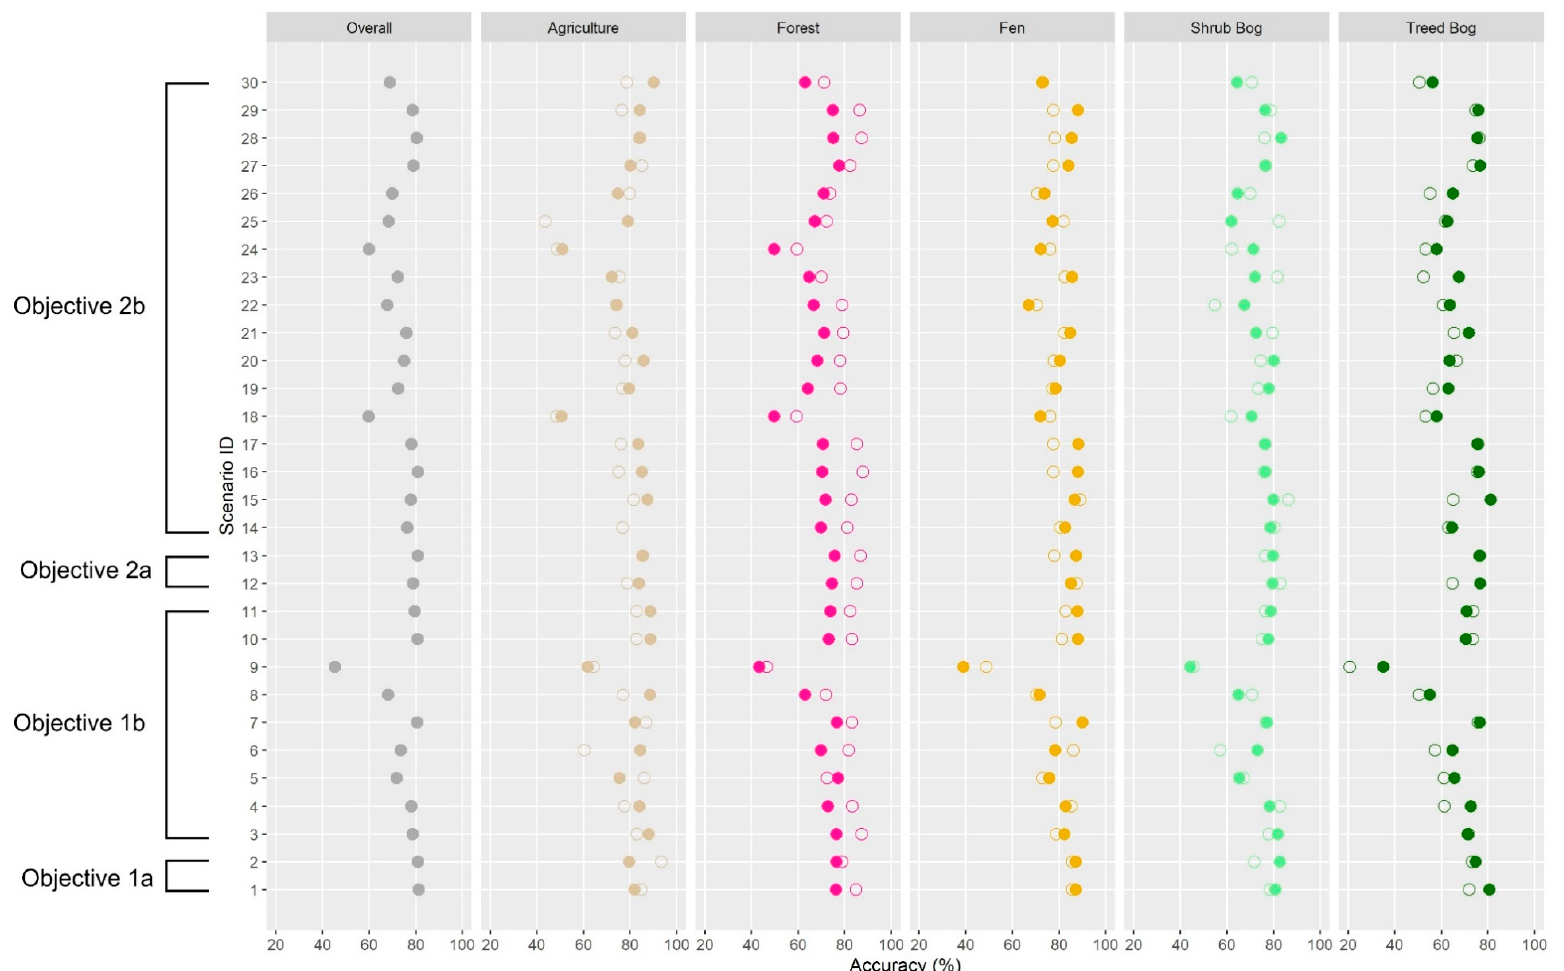
Figure 4. Overall, user’s, and producer’s accuracy per class for the 30 scenarios. Scenario information (including which variables are included in each) is listed in Table 2; hollow and solid circles represent producer’s and user’s accuracies, respectively. The objectives that each of the classifications address are indicated on the left.